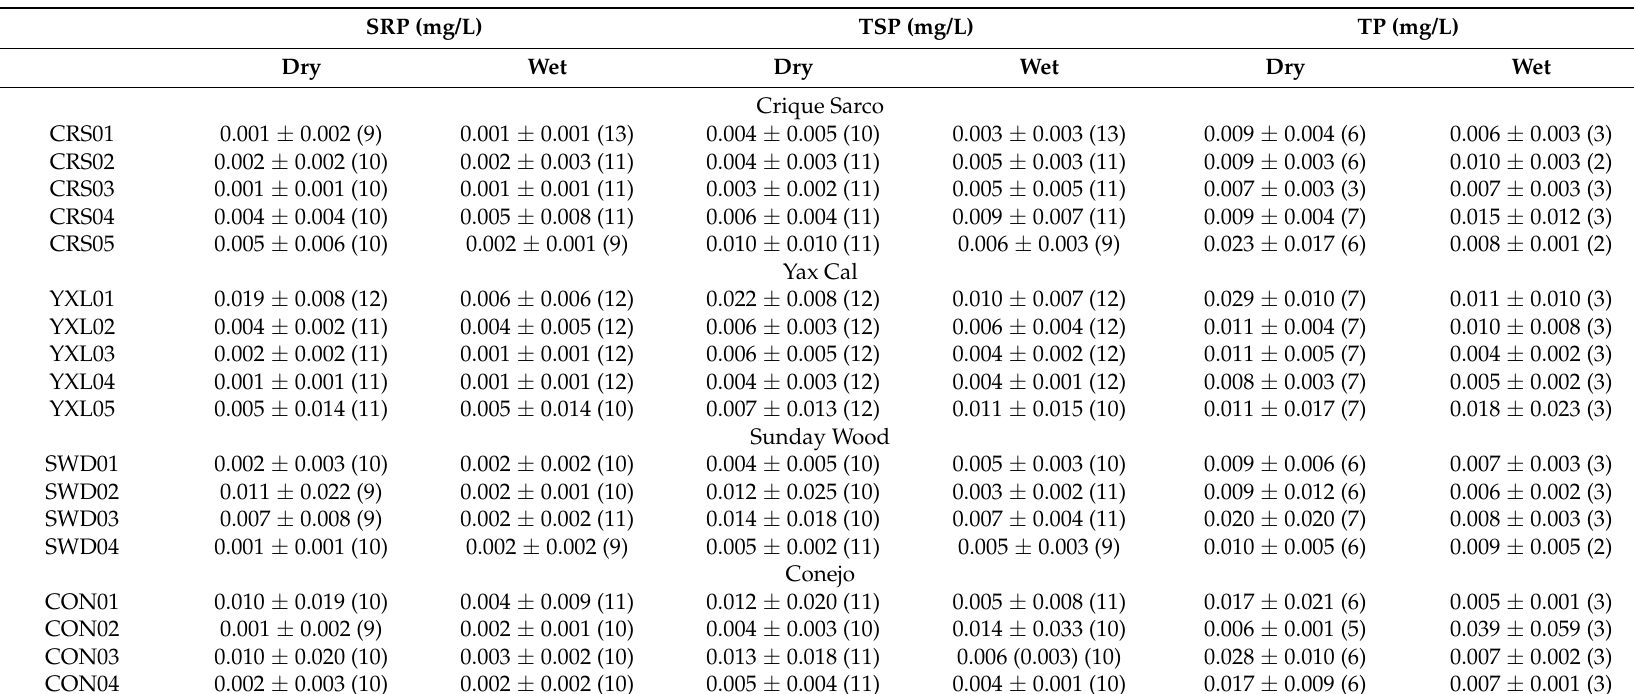
Table 5. Mean seasonal nutrient concentrations for soluble reactive phosphorus (SRP), total soluble phosphorus (TSP), and total phosphorus (TP) for all sampling sites within each study catchment. Values are mean ± 1 standard deviation (sample size in